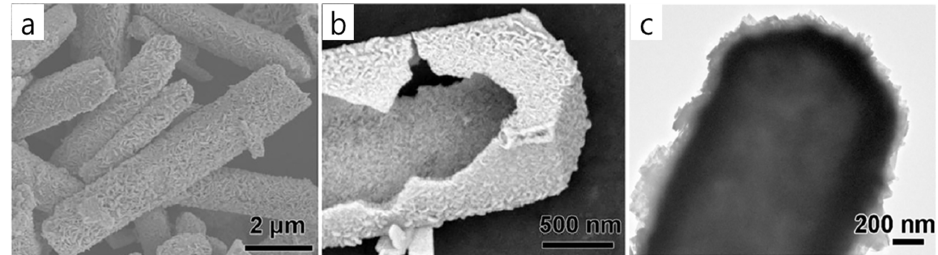
Figure 14. ( a , b ) SEM and ( c ) TEM images of hierarchical Bi 2 WO 6 nanorods, reprinted with permission from